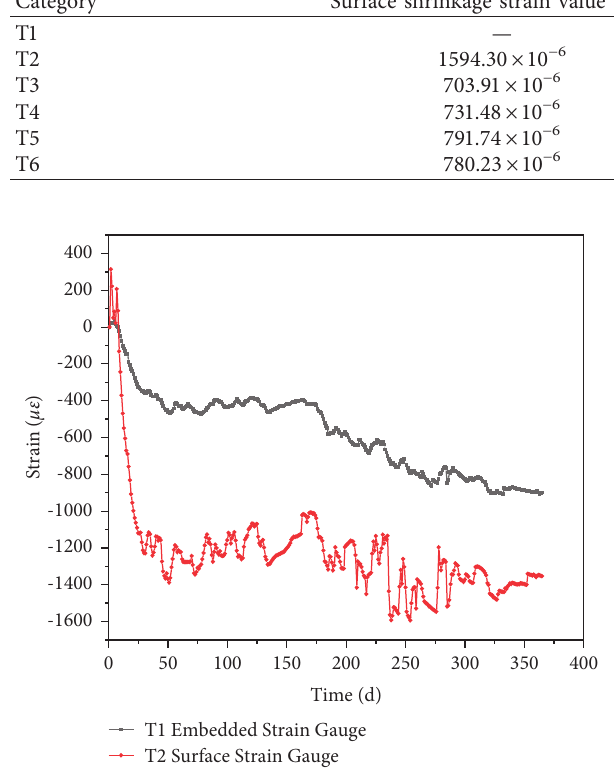
Figure 13: Strain curves of T1 and T2 specimens with